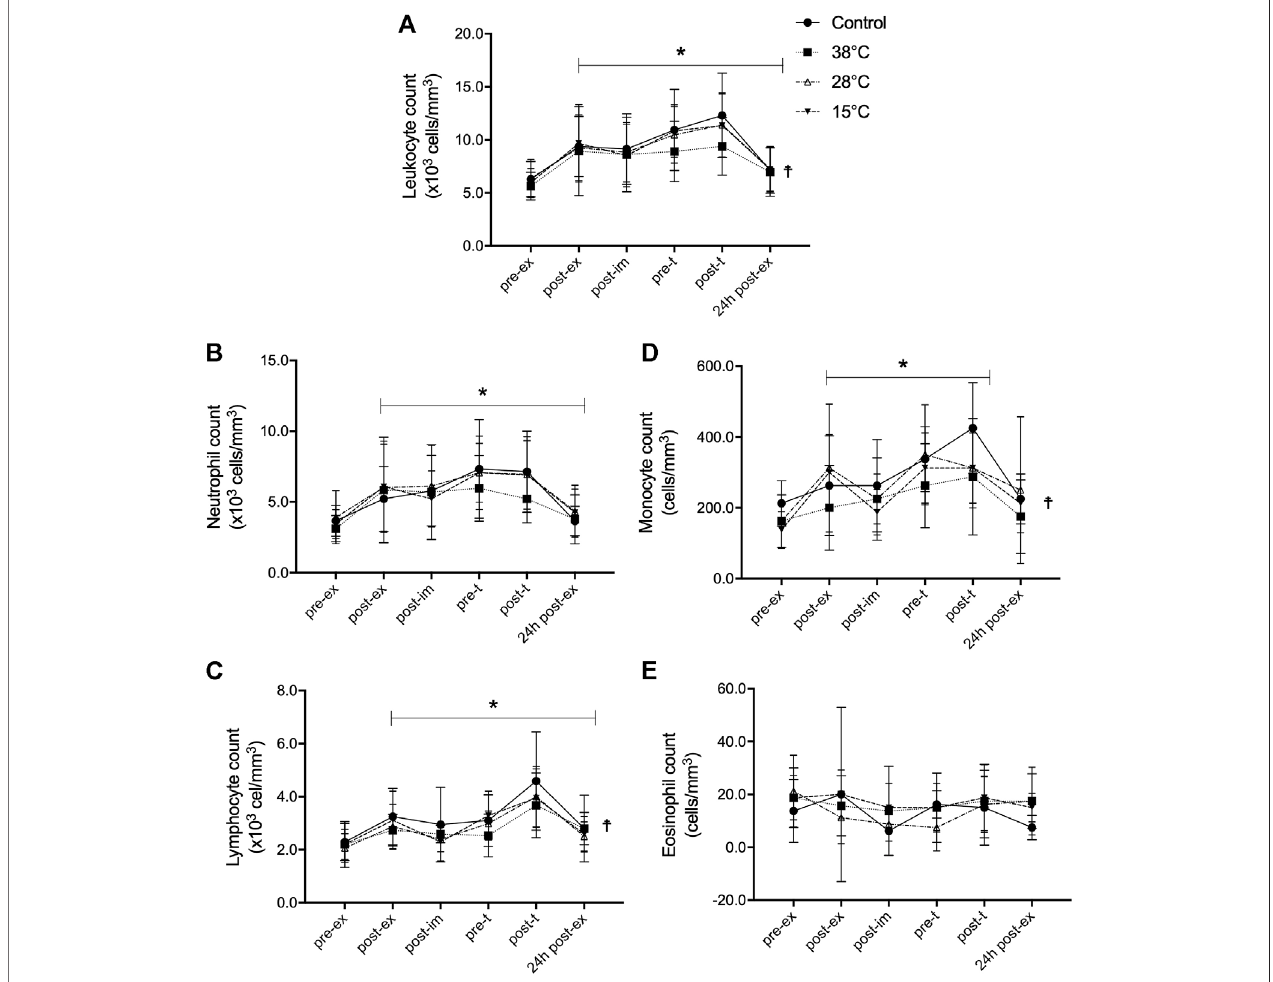
FIGURE 2 | Effectofpost-exercise recoveryby water immersiononthe globaland differentialleukocyte count.Leukocyte count (A) , neutrophil count (B) , lymphocyte count (C) , monocyte count (D) , and eosinhopil count (E) . * p < 0.05, main time effect, compared to pre-ex, repeated two-way ANOVA, followed by Dunnett ’ s multiple comparison test. ☨ p < 0.05, main treatment effect, 38 ° C versus control, repeated two-way ANOVA, followed by Dunnett ’ s multiple comparison test. Pre-ex – before exercise session, post-ex – immediately after exercise session, post-im – immediately post immersion, pre-t – immediately before performance tests, post-t – immediately post performance tests, 24 h post-ex – 24 h after the exercise